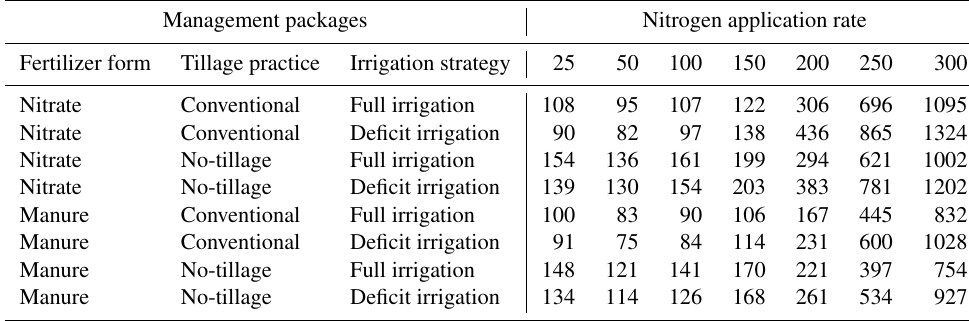
Table A2. Grey WF per tonne of crop production for the different management packages. Management packages